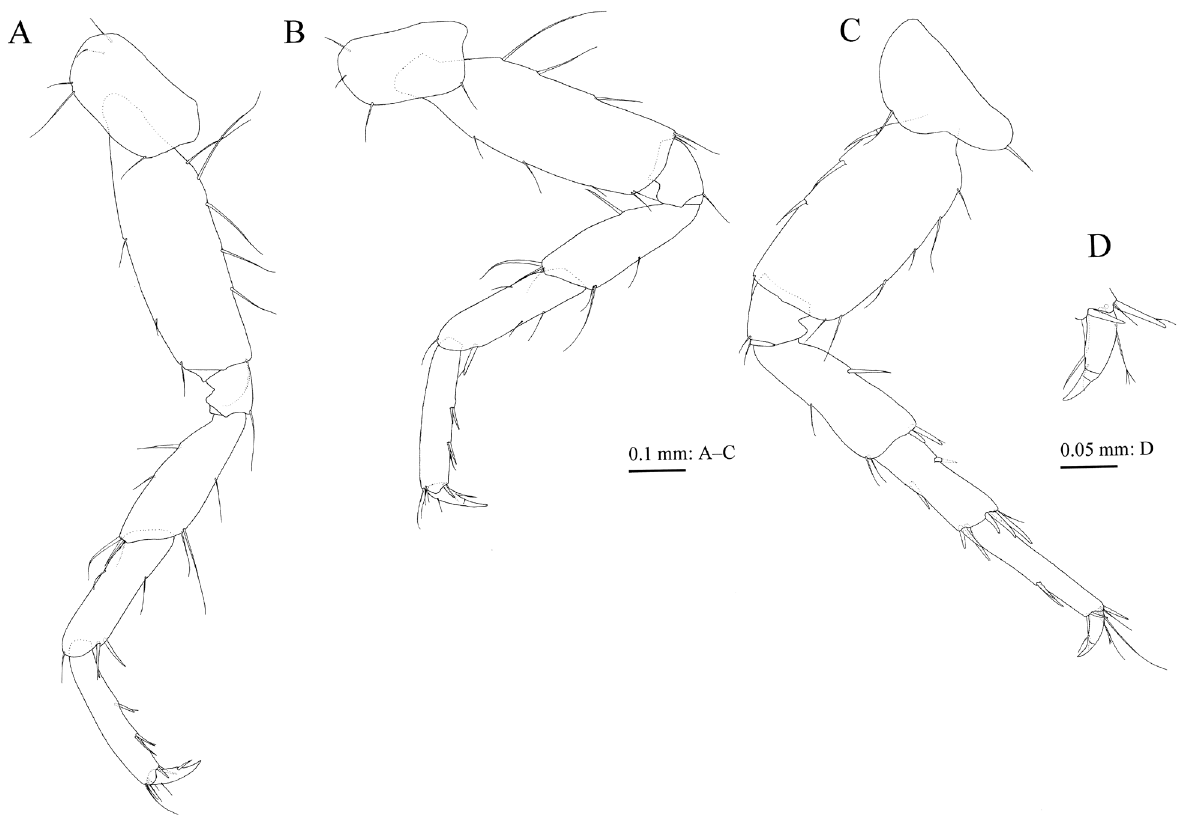
Figure 5. Pseudocrangonyx gudariensis Tomikawa & Sato, sp. n., holotype, male (3.9 mm), NSMT-Cr 24603. A pereopod 3, lateral view; B pereopod 4, lateral view; C pereopod 5, lateral view; D dactylus of pereopod 5, lateral